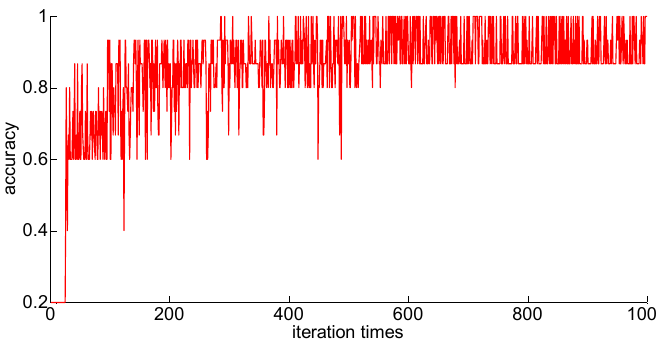
Figure 10. Fifty training samples of the neural network.